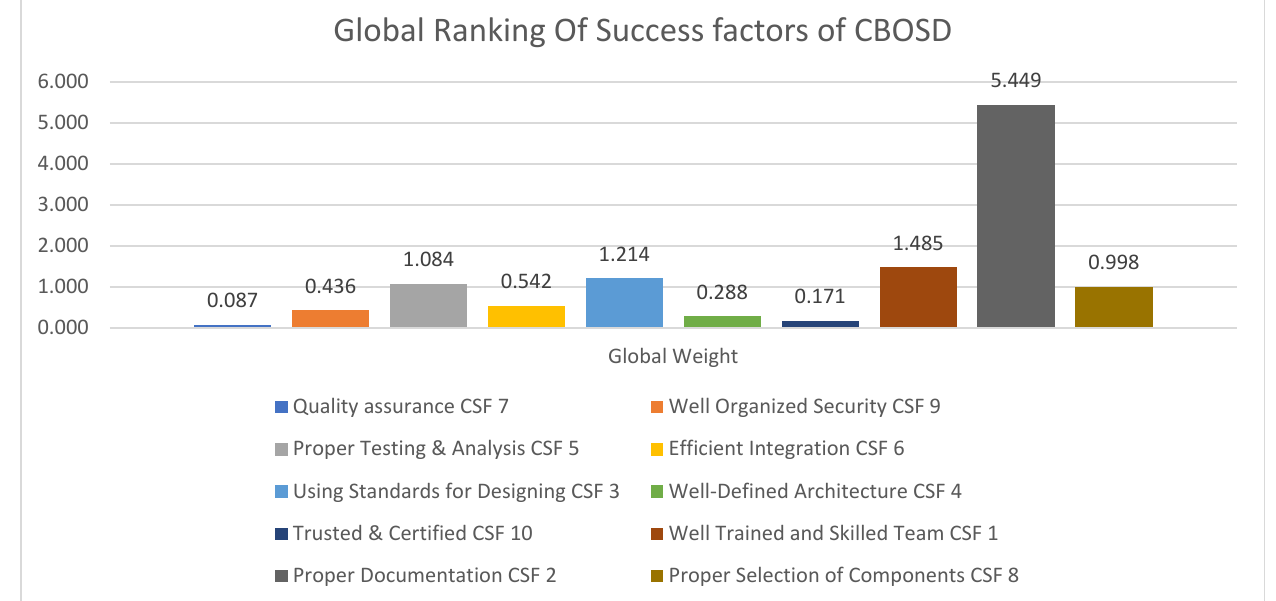
Table 26. Summary of local and global weights success factors and their rankings.